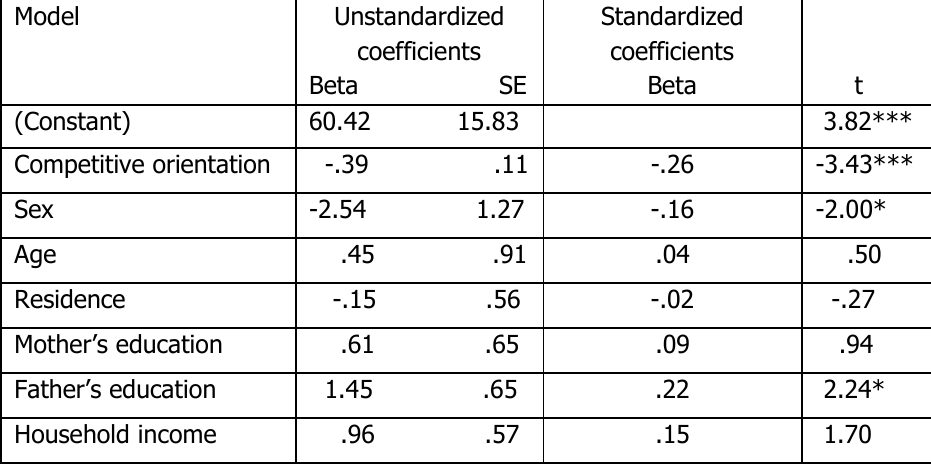
Summary of Linear Regression Analysis for the Emotional